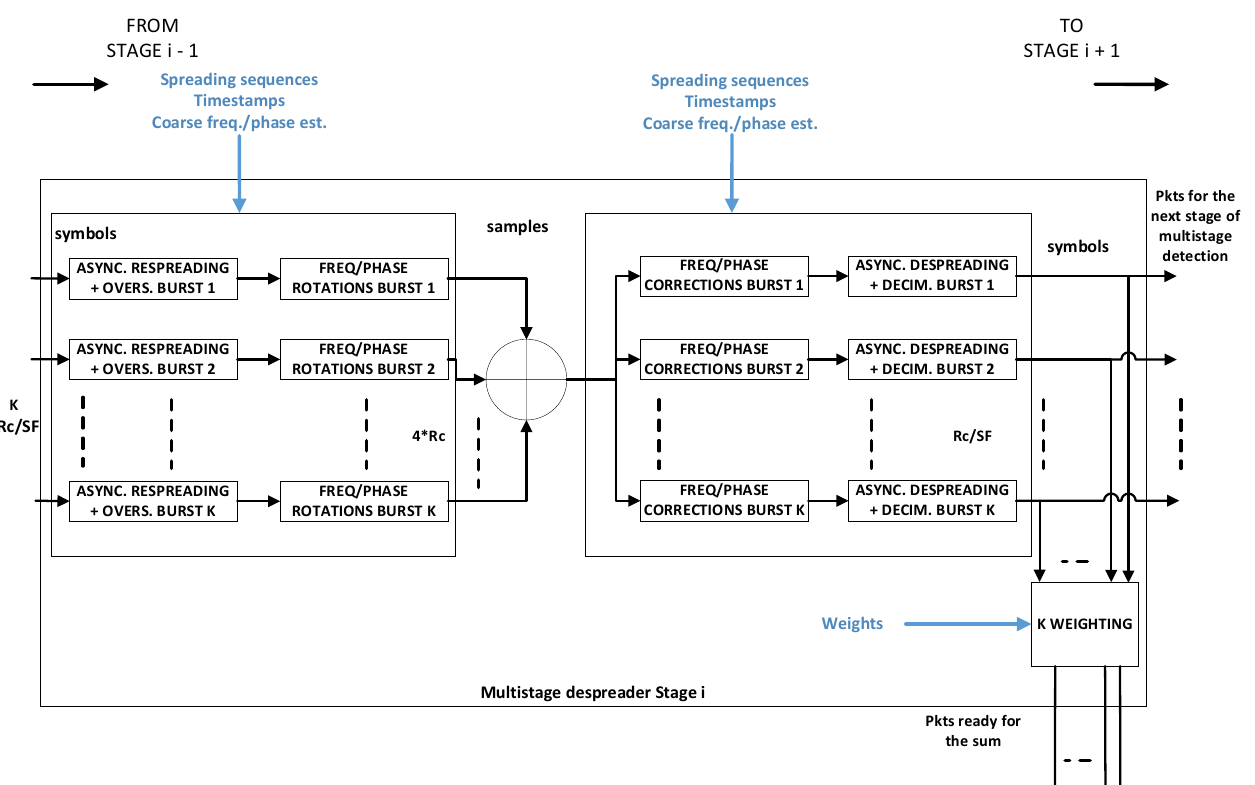
Figure 16. Generic i th stage of the multistage despreader.